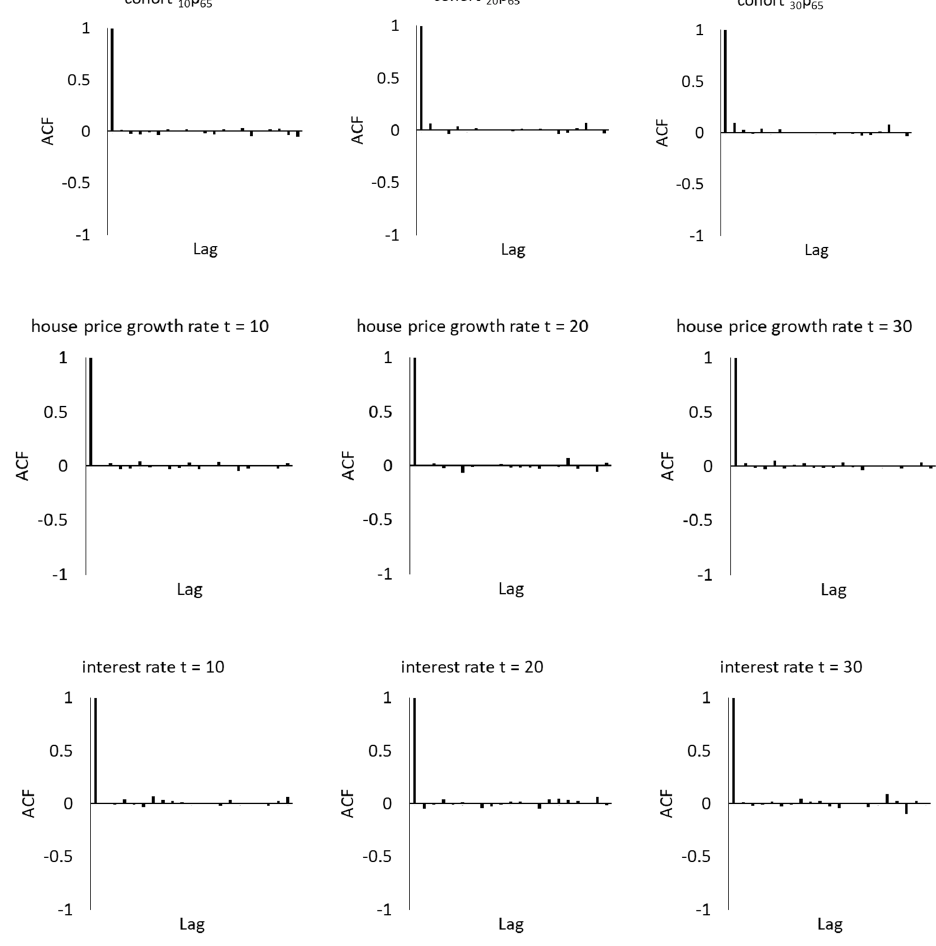
Figure A1. Sample autocorrelations between successive Markov chain Monte Carlo (MCMC) samples of future survival probabilities, house price growth rates and interest rates.